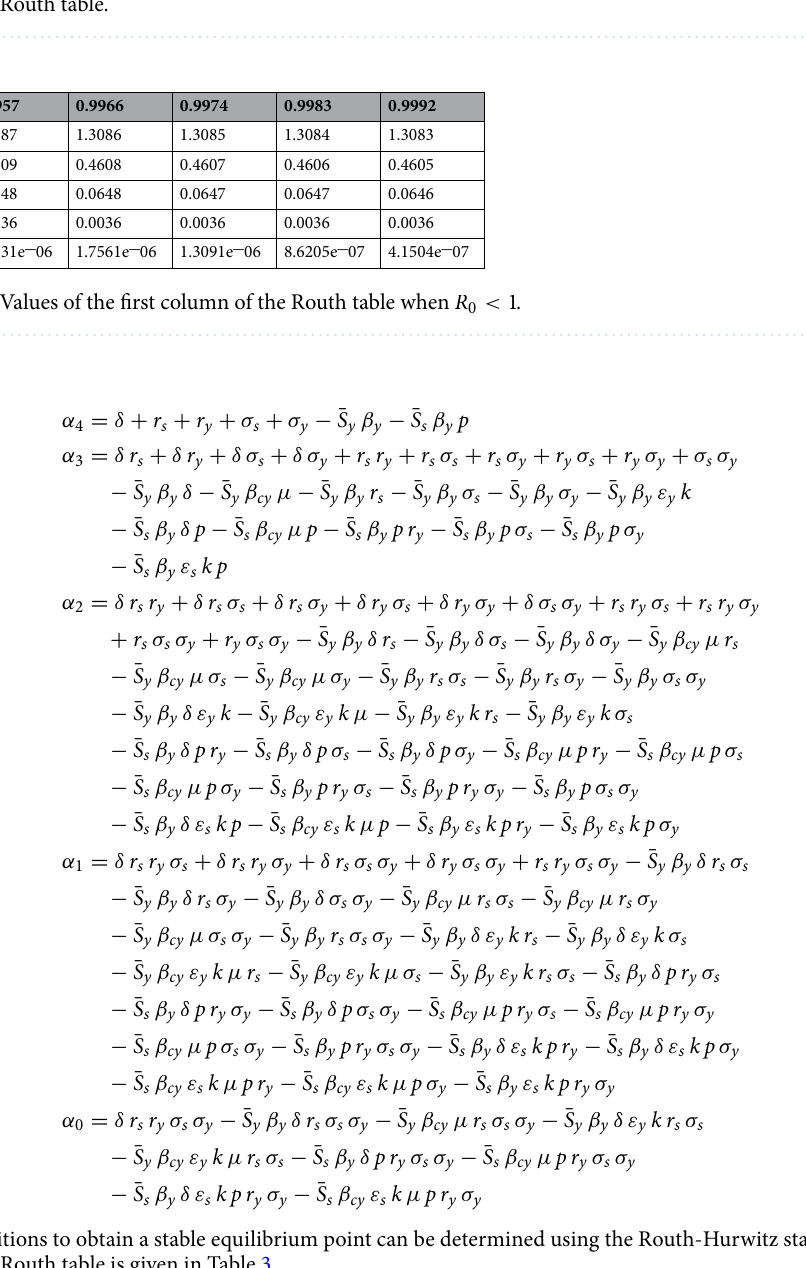
Table 3. Routh table.